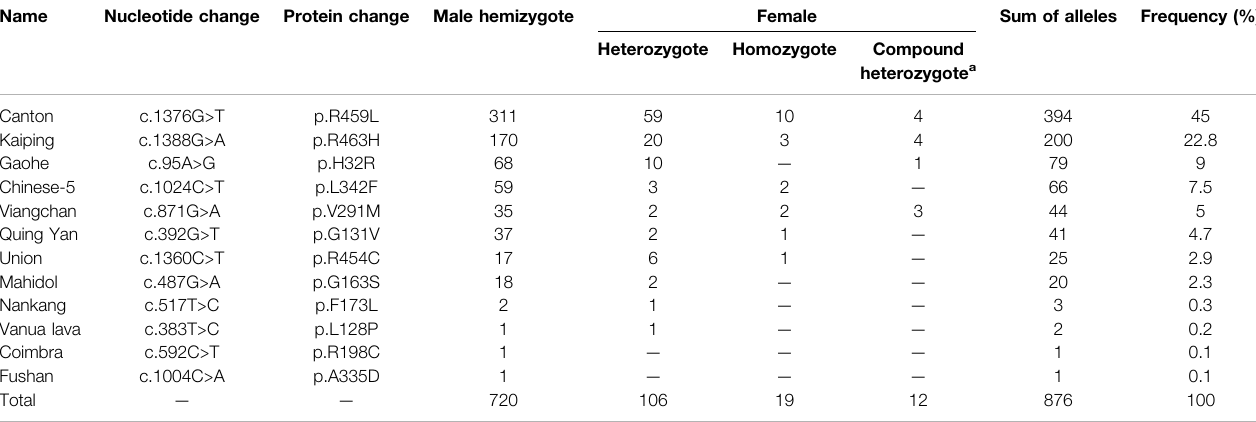
TABLE 1 | Allele frequencies of G6PD variants in 851